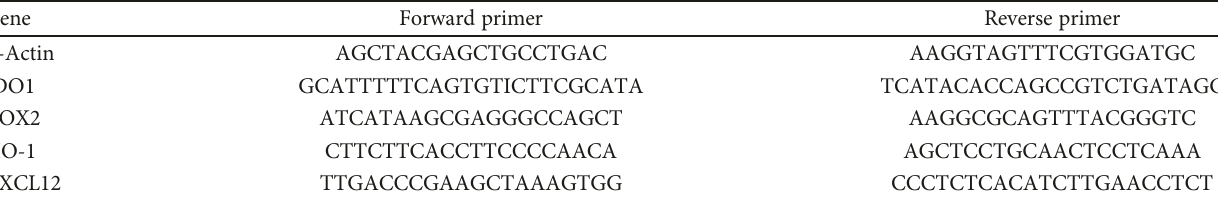
Table 1: Genes used in this study with the forward and reverse